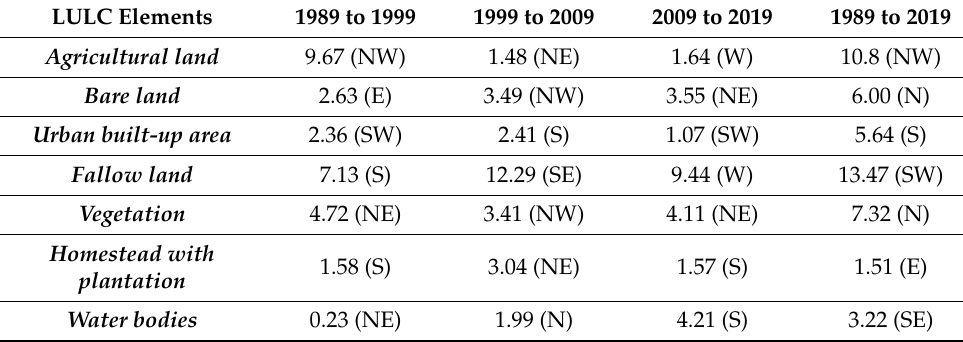
Table 7. Shifting distances (expressed in km) and directions of each LULC element. LULC